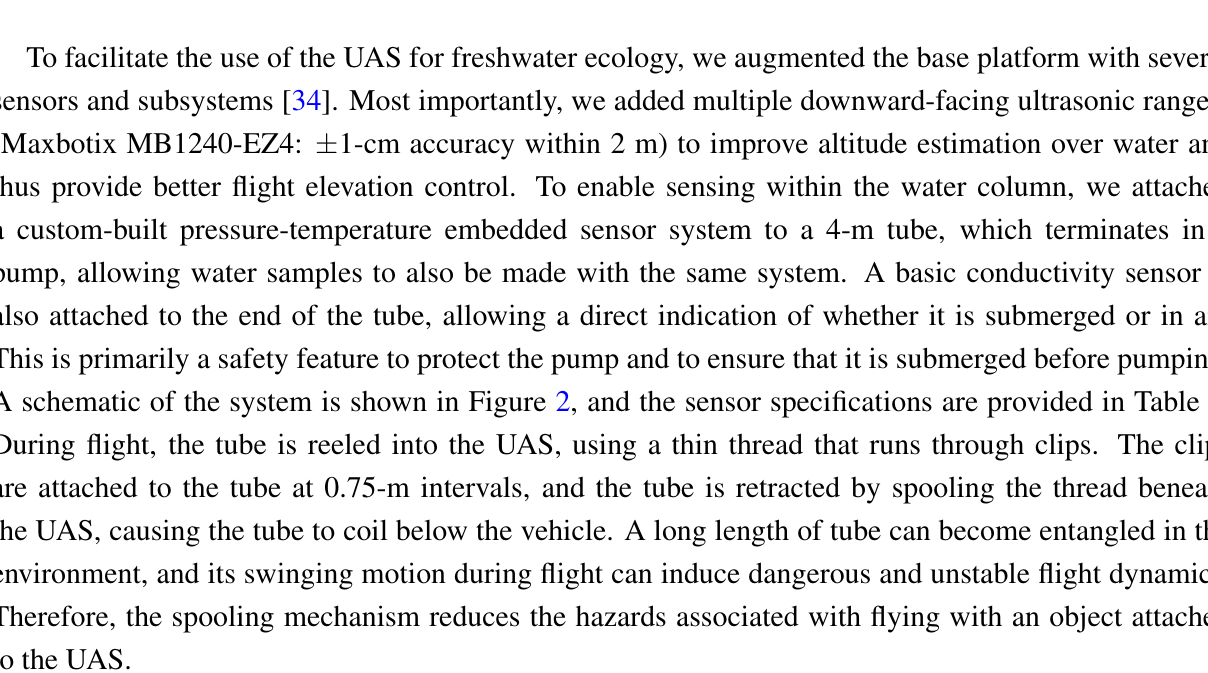
Figure 1. UAS in flight at Blue Oak Ranch